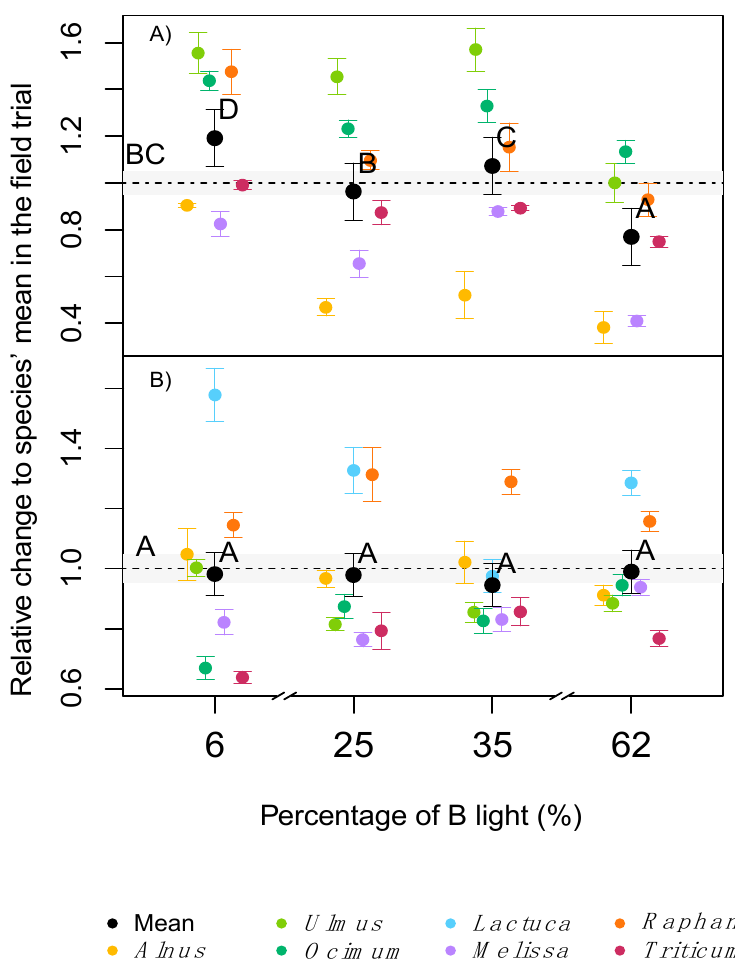
Figure 2. Fold change on: plant height ( A ) and SLA ( B ), relative to the average field trial (dotted line). Coloured dots are the average of each species in both experiment runs ( n = 18), the black dots are the average values across all 7 species ( n = 126). Error bars indicate the standard errors. The grey area corresponds to the standard error of the field trial. Di ff erent letters indicate statistical di ff erence between groups with experiment replicate and species as a random e ff ect.